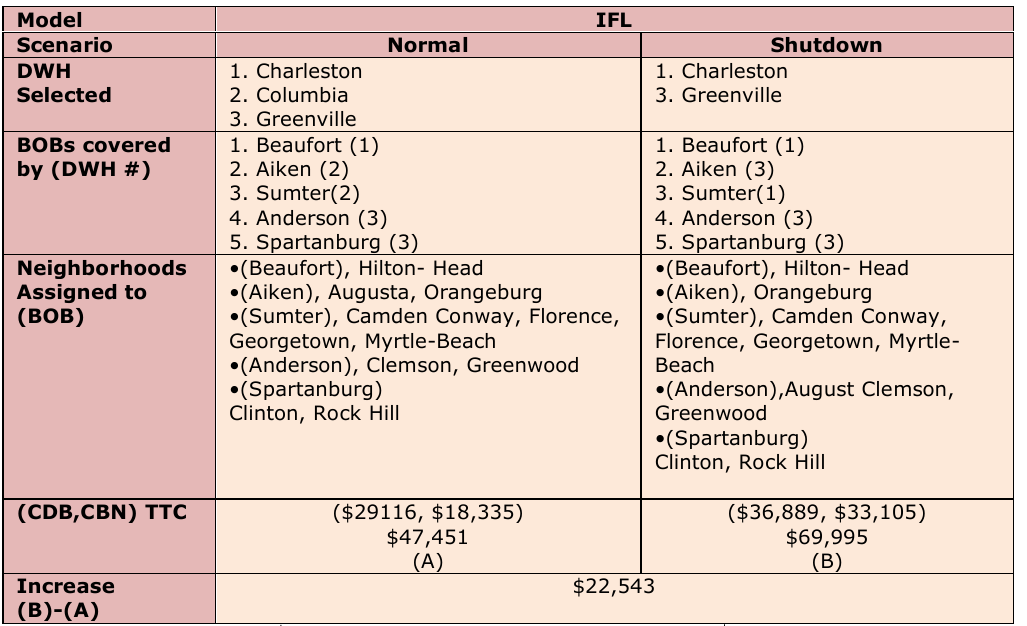
Table 2(a). Results comparison for normal/shutdown scenarios for three